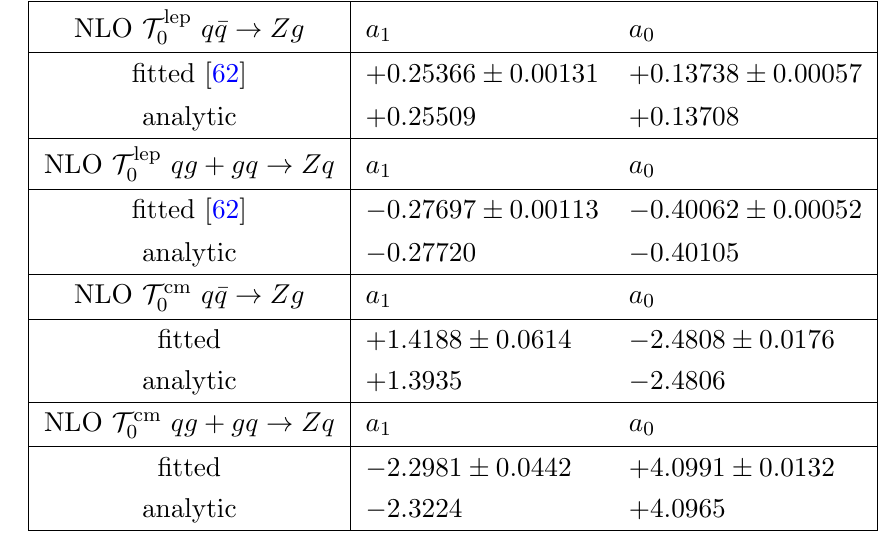
Table 1 . Comparison between our analytic predictions and the (cid:12)tted results for the LL a 1 and NLL a 0 coe(cid:14)cients in Drell-Yan production. These (cid:12)tted values for a 1 and a 0 with the leptonic de(cid:12)nition and the analytic results for a 1 were already given in ref.